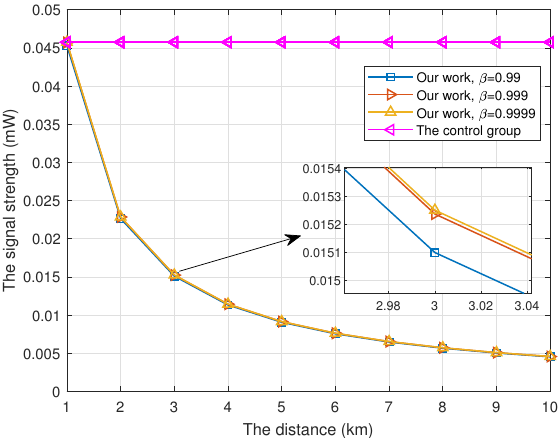
Figure 4. The signal strength vs. the